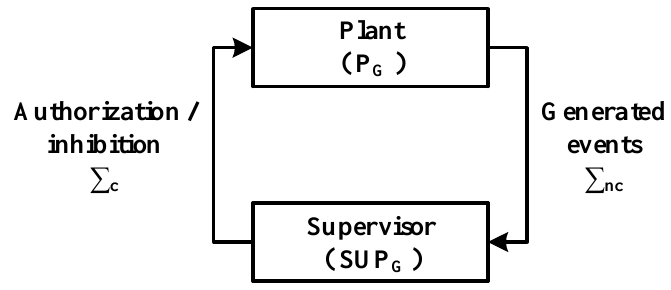
Figure 2. SCT-based centralized control.